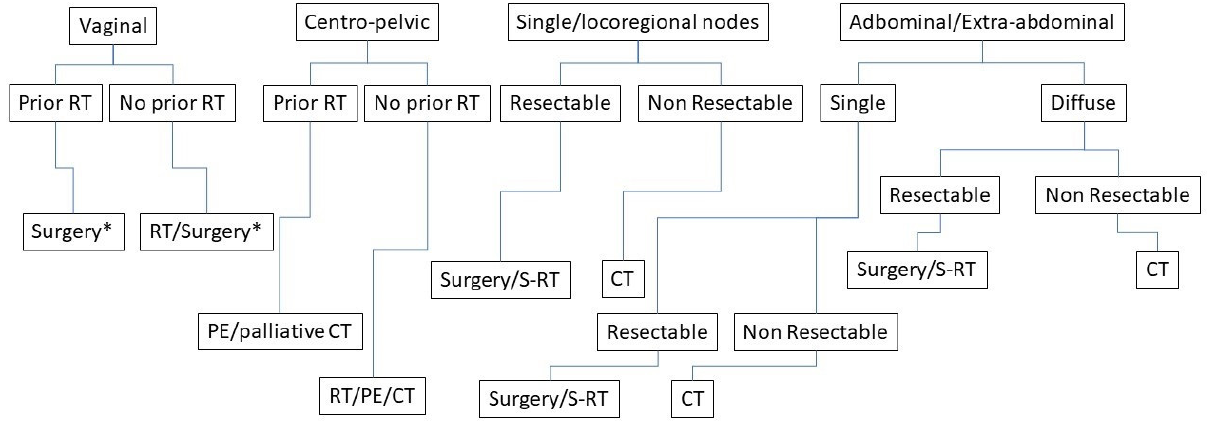
Figure 2. Flowchart of treatment of recurrence. RT = radiotherapy; CT = chemotherapy; * Partial/Total colpectomy.